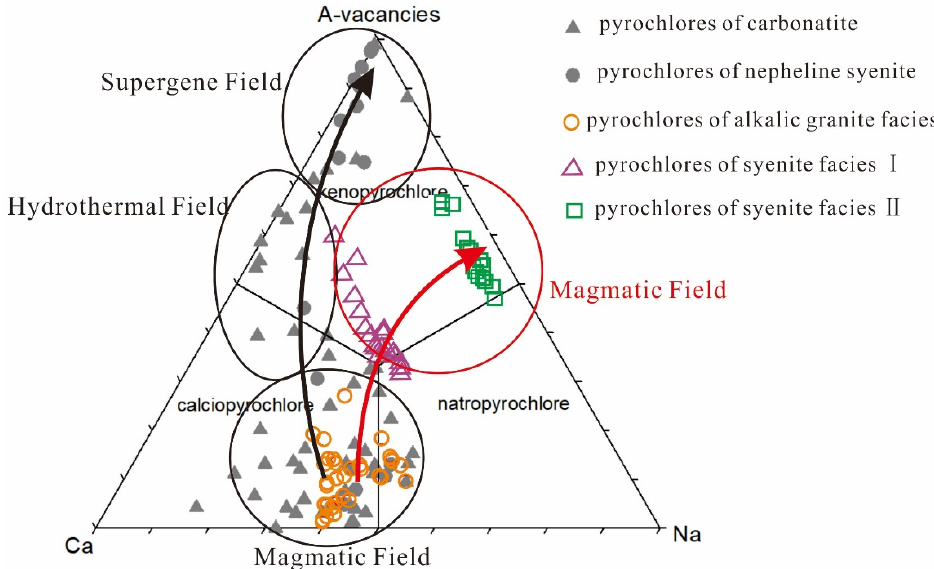
Figure 8. Ternary plot of Ca, Na and A-site vacancy (modified from [36]). The magmatic, hydrother- mal and supergene fields of pyrochlore supergroup minerals (black circles) are from [36]. The black arrow indicates the compositional evolution of pyrochlore supergroup minerals from carbonatite. The magmatic field of pyrochlore supergroup minerals from the Boziguoer deposit (red circle) is proposed based on the results presented in this study. The red arrow indicates their compositional evolution. The pyrochlore supergroup mineral data for carbonatite are from [23,31,37,41]; data for nepheline syenite are from [35].